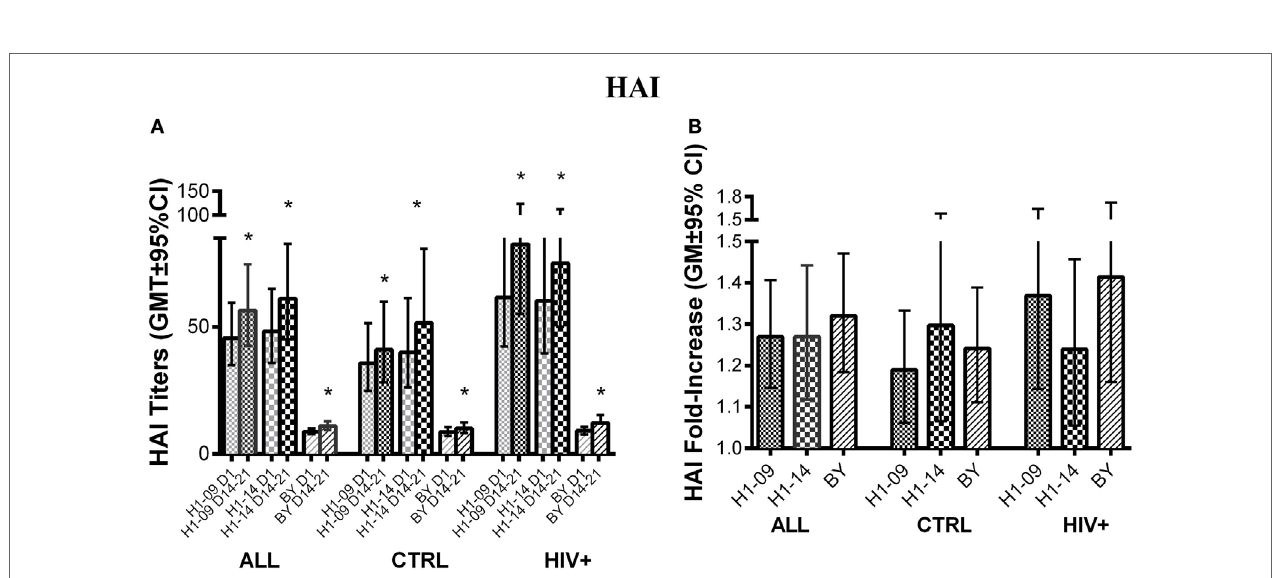
FigUre 3 | antibody responses to laiV4 measured by hai . The data were derived from 45 HIV-infected and 55 uninfected individuals. (a) Absolute responses in each group of participants, as indicated below the abscissa, at V1 (before vaccination) and V4 (14–21 days after vaccination) and against the viruses indicated in the labels of the abscissa. Asterisks (*) indicate significant differences between pre- and post-vaccination. (B) Fold-increases from pre- to post-vaccination. There were no significant differences across viruses or by HIV status.